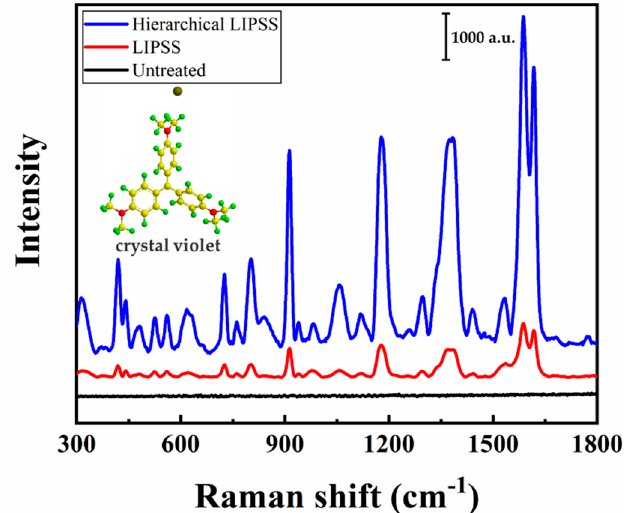
Figure 4. Raman spectra obtained from untreated, LIPSS, and hierarchical LIPSS substrates, respectively.